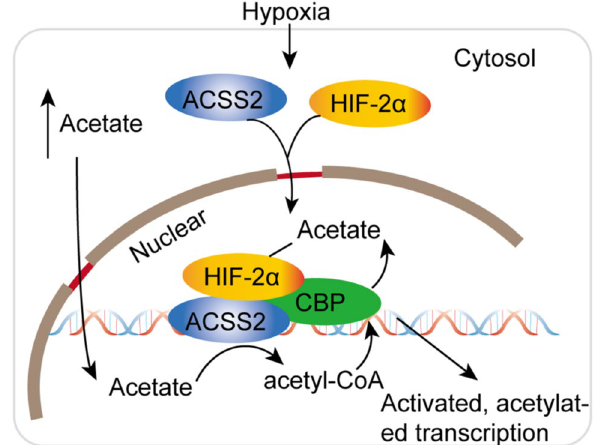
Fig. 3 ACSS2 utilizes acetate to activate and acetylate transcription factors under hypoxic conditions. Under hypoxic conditions, acetate, ACSS2, and the transcription factor HIF enter the nucleus. In the nucleus, the acetate concentration increases, and HIF-2α is acetylated